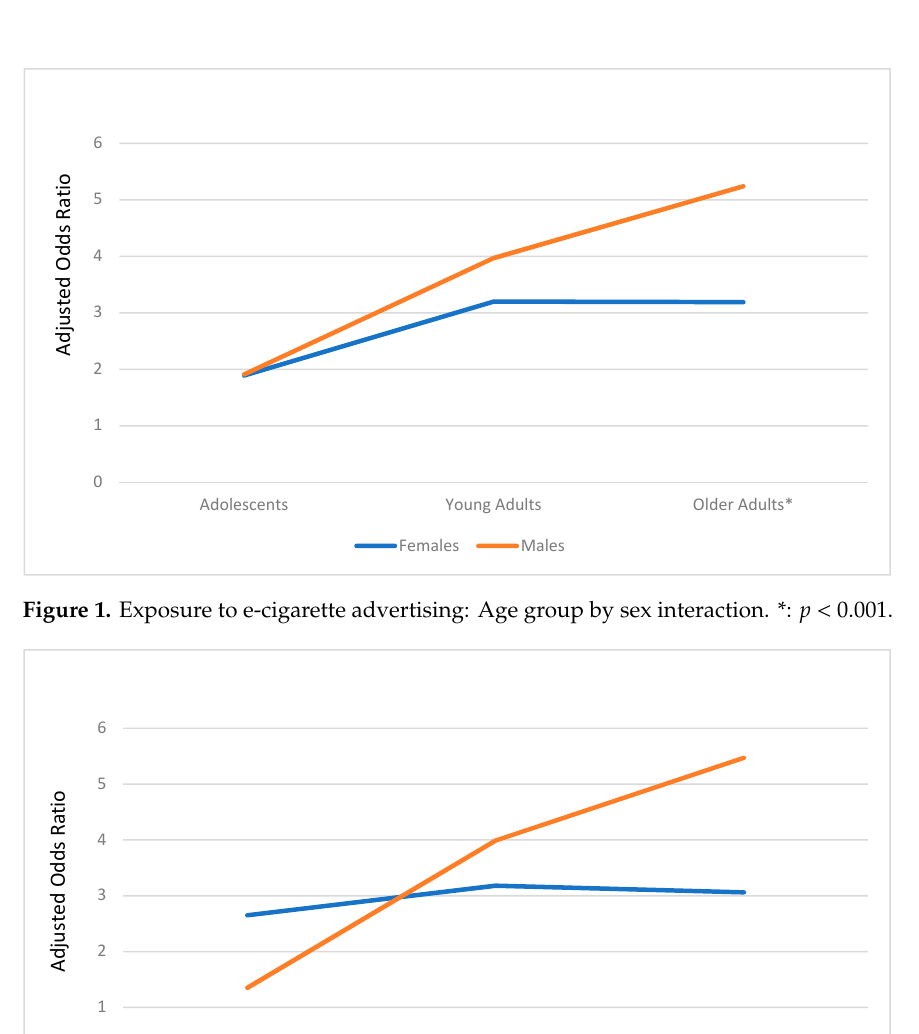
* p -values test the di ff erence between odds within sex and within cigarette smoking status.